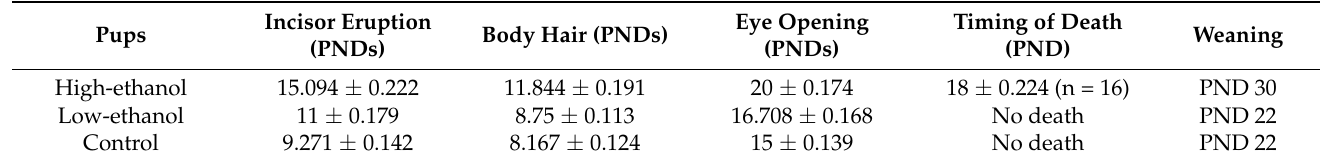
Table 1. Effects of lactational ethanol exposure on landmarks of physical growth in rat pups.